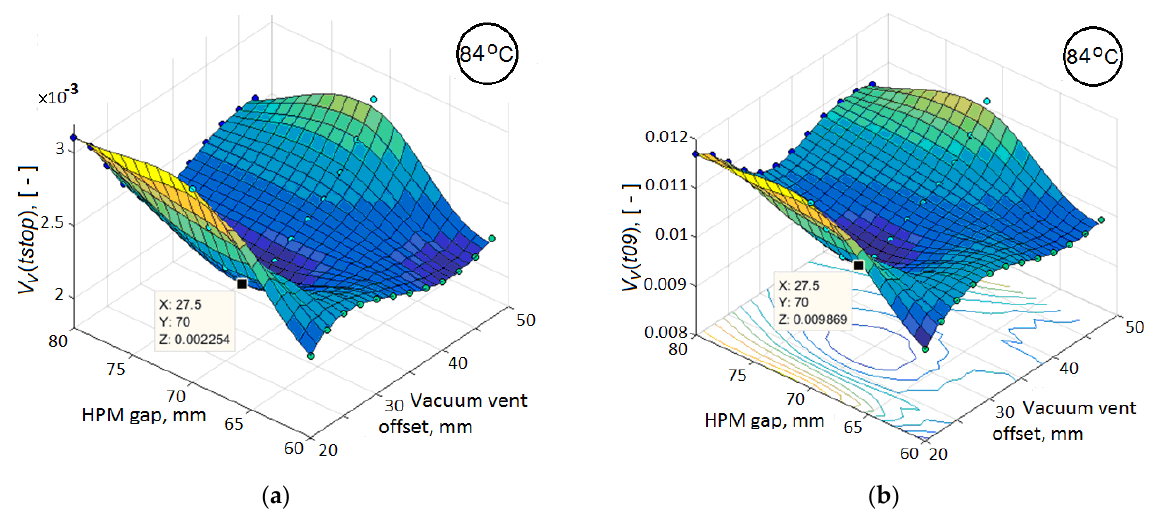
Figure 6. The response functions of the residual void volume V v in the preform on the parameters of the vacuum vent location: ( a ) at the time instant when motion of the resin stopped; ( b ) at the moment t 09 .